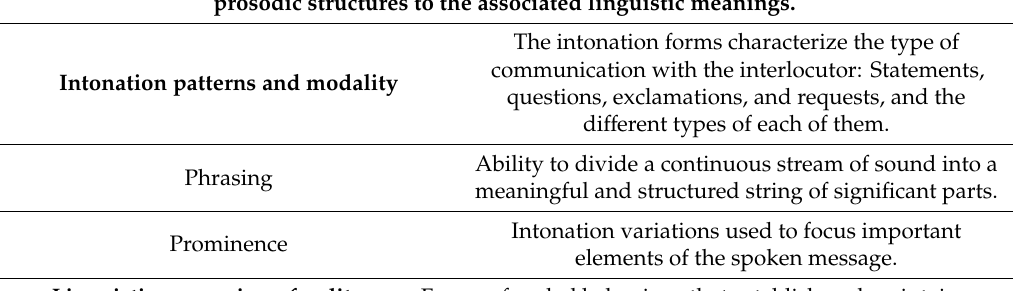
Table 1. Definitions of the prosodic concepts used in the educational